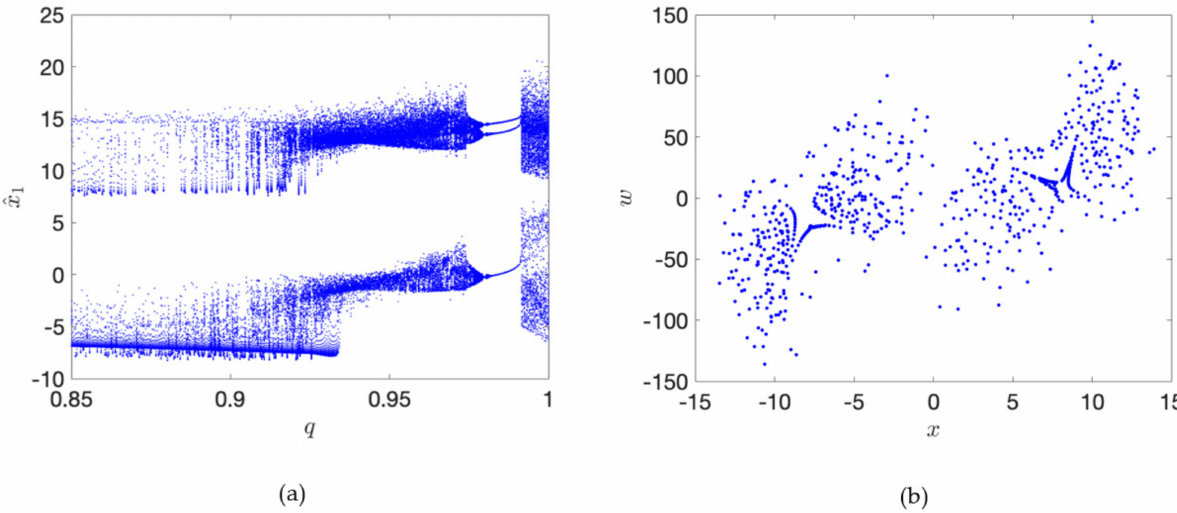
Figure 4. ( a ) Bifurcations diagrams of System (44) for q with T eq = 0, and a 1 = 10. ( b ) Poincar é section on x − w plane at z =